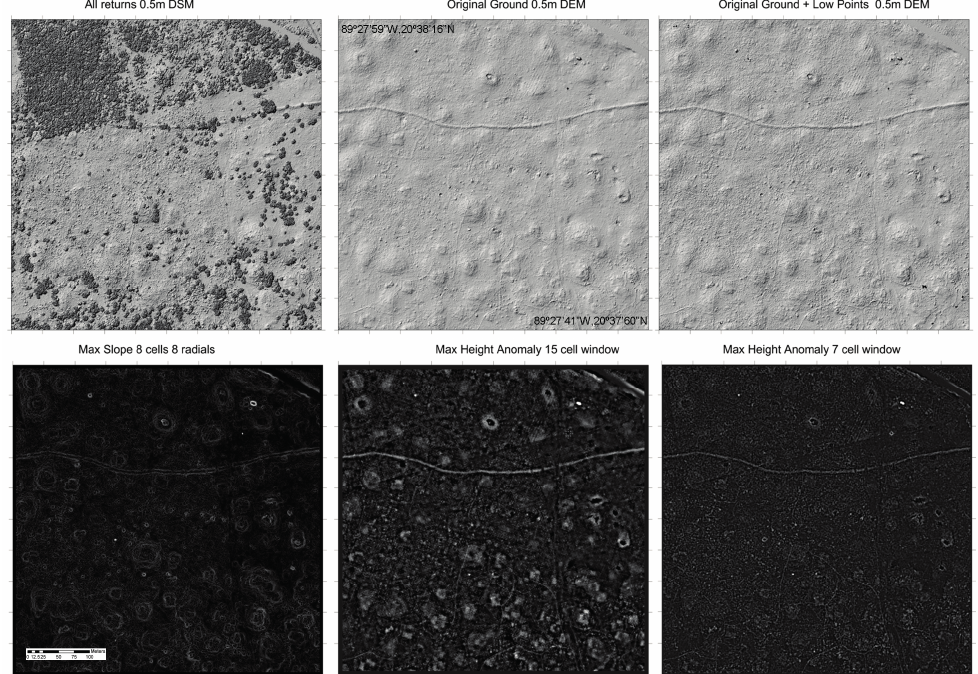
Figure 7. Comparison of several LiDAR-derived map products used for identification and mapping of archaeological features. Figure created by Juan Carlos Fernandez Diaz (NCALM—http://ncalm.cive.uh.edu)